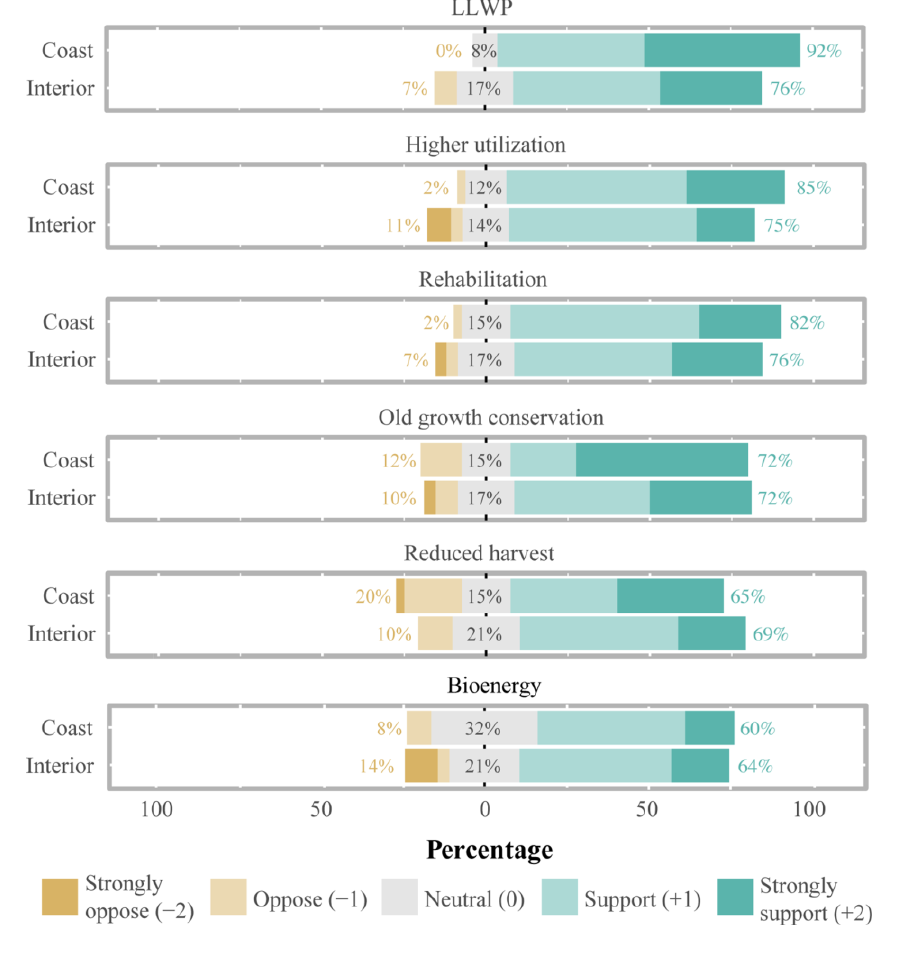
Figure 8. Degree of support for, or opposition to the strategies, as indicated in the individual post-workshop survey.